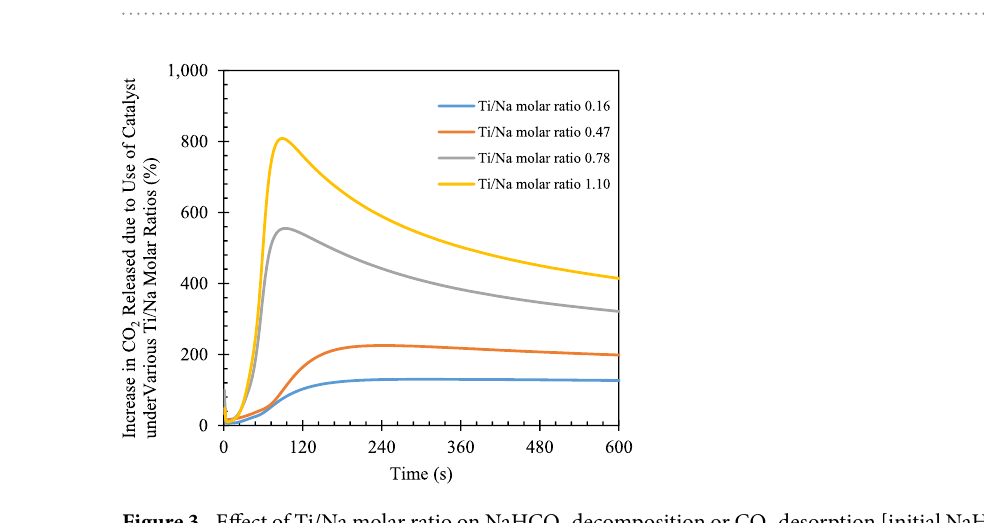
Figure 2. NaHCO 3 decomposition or CO 2 desorption profiles under different stirring rates [initial NaHCO 3 concentration: 0.143 mol/L; Ti/Na molar ratio: 0.78; reaction temperature: 70 °C; N 2 flow rate: 500 mL/min].